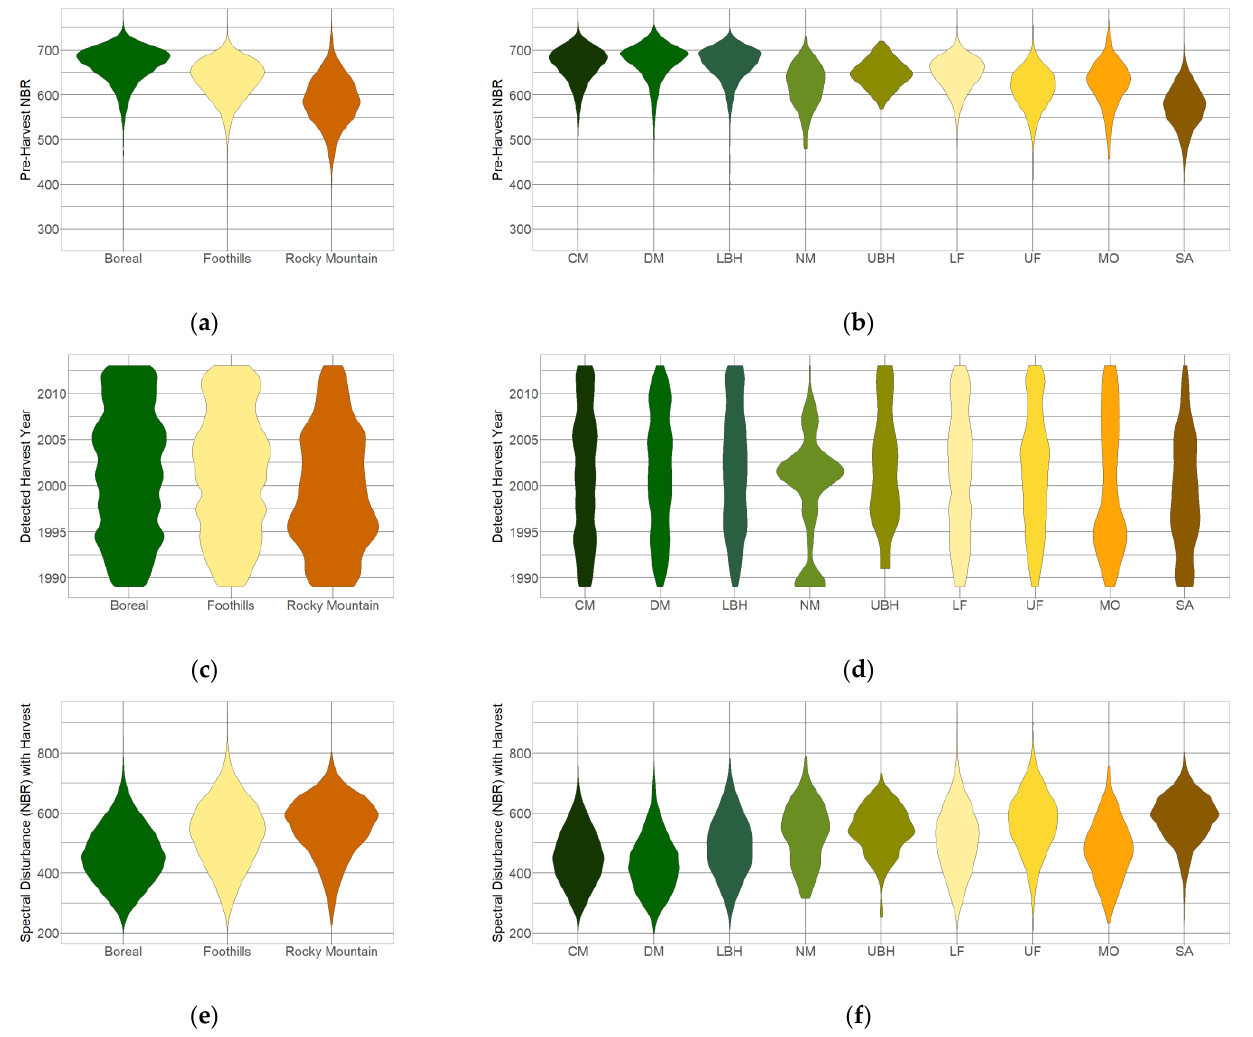
Figure 7. Violin plots showing the distributions by Natural Region ( a , c , e ) and Natural Subregion ( b , d , f ) for NBR preDistb ( a , b ), Harvest yr ( c , d ), and NBR totDistb ( e , f ). CM: Central Mixedwood; DM: Dry Mixedwood; LBH: Lower Boreal Highlands; NM: Northern Mixedwood; UBH: Upper Boreal Highlands; LF: Lower Foothills; UF: Upper Foothills; MO: Montane; SA: Subalpine.